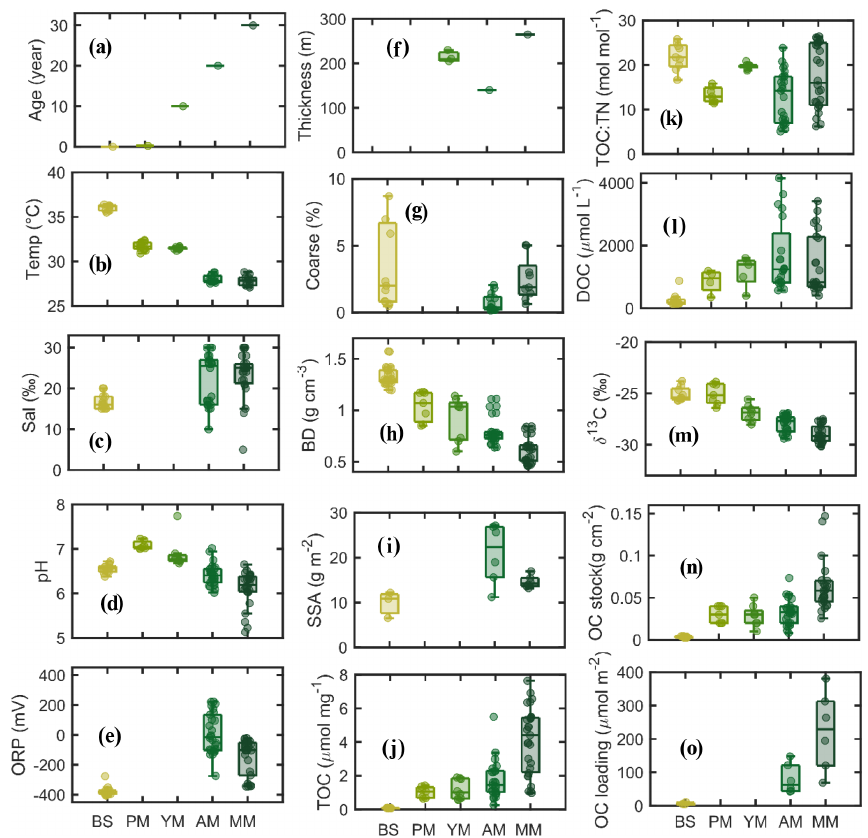
Figure 2. Boxplot diagrams of physical and biogeochemical parameters in the sediment subsamples according to mangrove development.